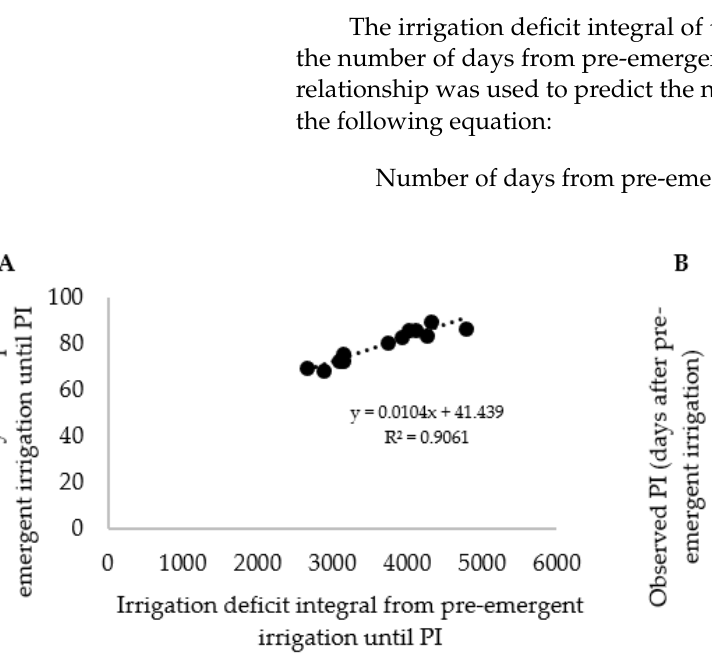
Figure 3. ( A ) Irrigation deficit integral from pre ‐ emergent irrigation until PI versus the number of days from pre-emergent irrigation until PI (n = 13). ( B ) Modelled versus predicted number of days to PI with black dots representing parameterizing data and red dots the validating data. The RMSE of the parameterizing data (RMSEp) totaled 2.1 days and the validating data (RMSEv) 1.8 days.